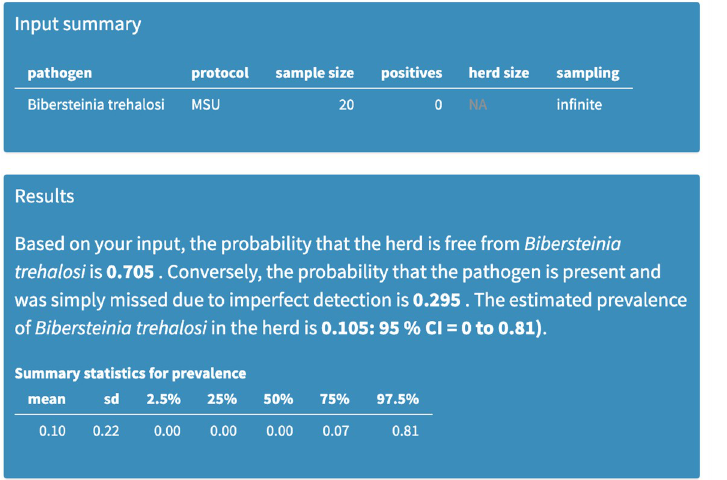
(S1 Fig). The estimated true prevalence of the pathogen in the herd was c TP ¼ 0 : 004 (infinite population: ([95% CI = 0.0–0.06]). These results are in close agreement with the finite sam- pling model ( small sample size (n = 16) relative to the herd size (N = 160) (S2 Fig).